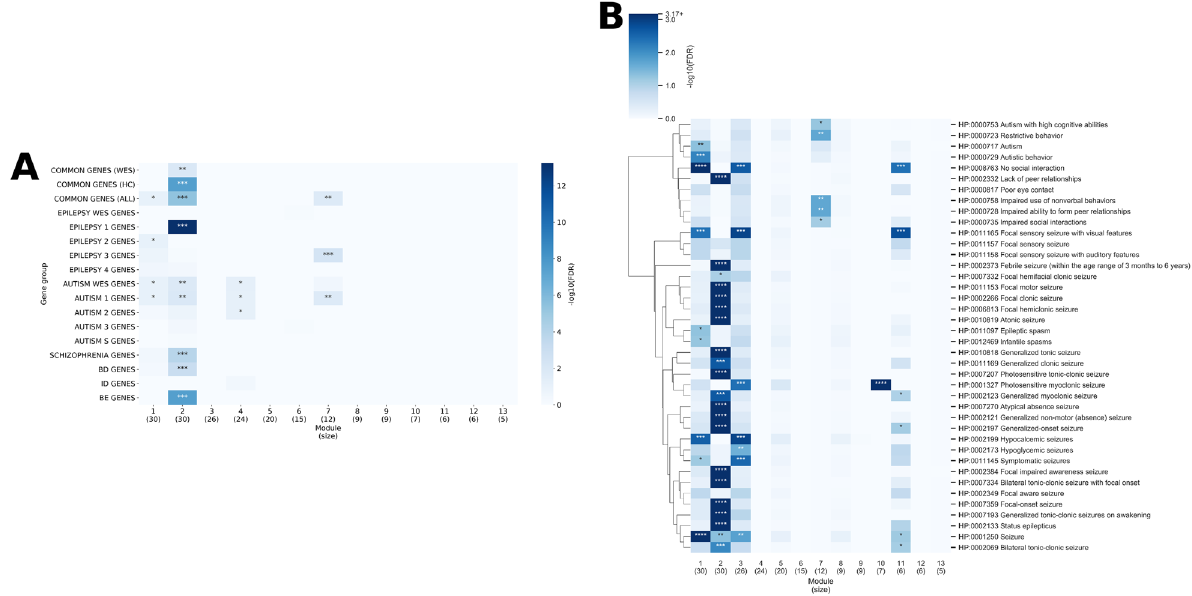
Figure 6. Enrichment analysis on modules in the multiplex network generated with WES epilepsy and autism genes. The enrichment analysis of ( A ) different gene groups and ( B ) epilepsy and autism phenotypes over the 13 largest modules (those that have at least 5 genes) in the multiplex network generated using only WES epilepsy and autism genes. ( A ) The hypergeometric test was used to determine the p-value for enrichment in each gene group. The false discovery rate (FDR) is reported since multiple gene groups were tested. The background of the hypergeometric test is the 294 genes in the network. COMMON GENES (WES) = genes in both the epilepsy and autism WES gene lists, COMMON GENES (HC) = genes that are both in the epilepsy 1 subgroup and autism 1 subgroup (high confidence), COMMON GENES (ALL) = all genes in an epilepsy subgroup and autism subgroup, BD = bipolar disorder, ID = intellectual disability, BE GENES = genes that have a significantly higher expression in brain tissue vs control tissue. ( B ) The first cluster of HPO terms represent autism phenotypes and the rest represent epilepsy phenotypes. Only HPO IDs with gene-HPO relationships in the Phen2Gene knowledgebase are shown. The p-value was determined by computing the mean gene-phenotype association score for each HPO ID over the genes in the module and comparing it to the mean of 10,000 trials using n genes, where n is the size of the module, randomly chosen from the 294 genes in the WES multiplex network. The FDR is reported since multiple HPO IDs were tested. For both ( A ) and ( B ) “***” denotes FDR < 0.01, “**” denotes FDR < 0.05, and “*” denotes FDR < 0.1 and for ( B ) “****” denotes FDR < 0.0001. The heatmap and cluster map were generated using seaborn version 0.10.0 (https ://seabo rn.pydat a.org/). The linkage on the rows of the cluster map was generated based on the distance between HPO IDs in the HPO